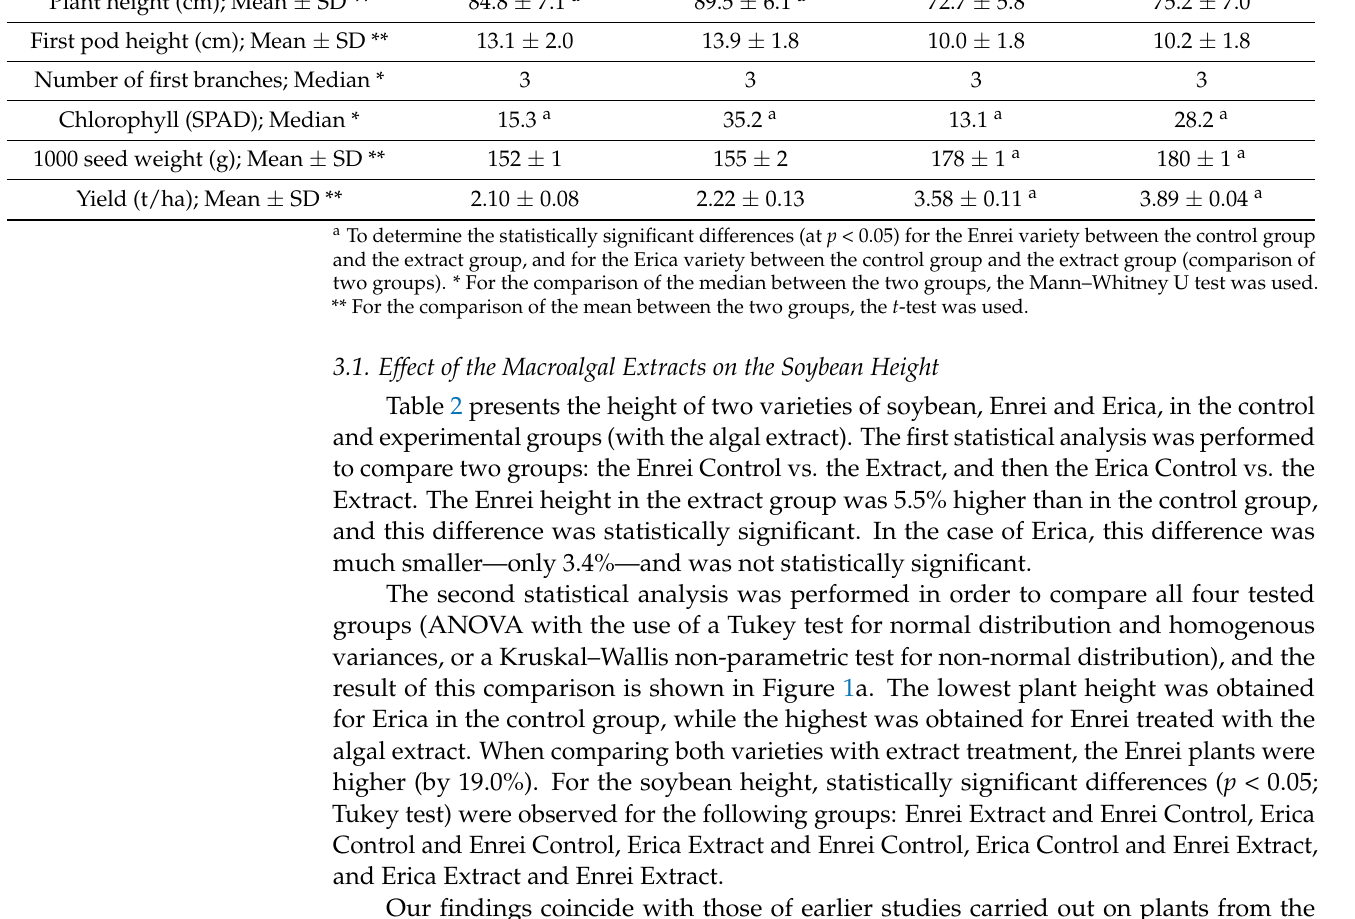
Table 2. Comparison of the soybean traits in the control group and the algal extract-treated group. Enrei Erica Parameter Control Extract Control